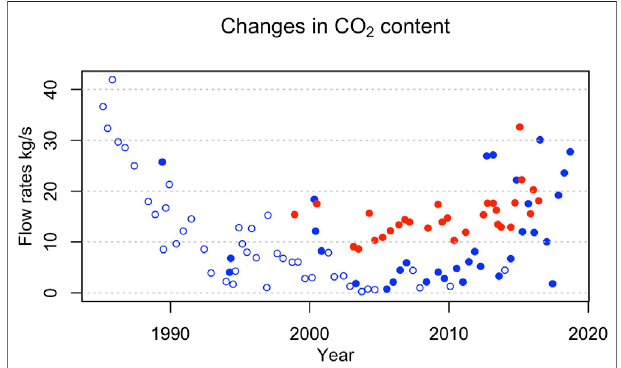
FIGURE 11 | Comparison between the absolute value of simulated fl ow rates (blue) and measured CO 2 diffuse degassing (red) (Cardellini et al., 2017). Open symbols refer to fl uid leaving the reservoir, while the solid dots refer to the fl uid entering the reservoir.